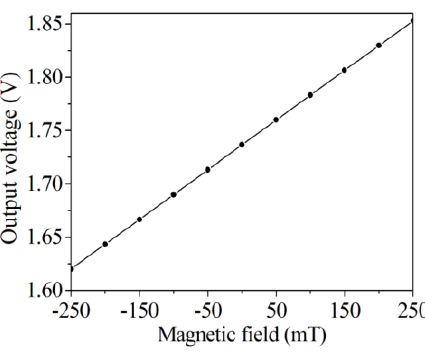
Figure 7. Output voltage of the readout